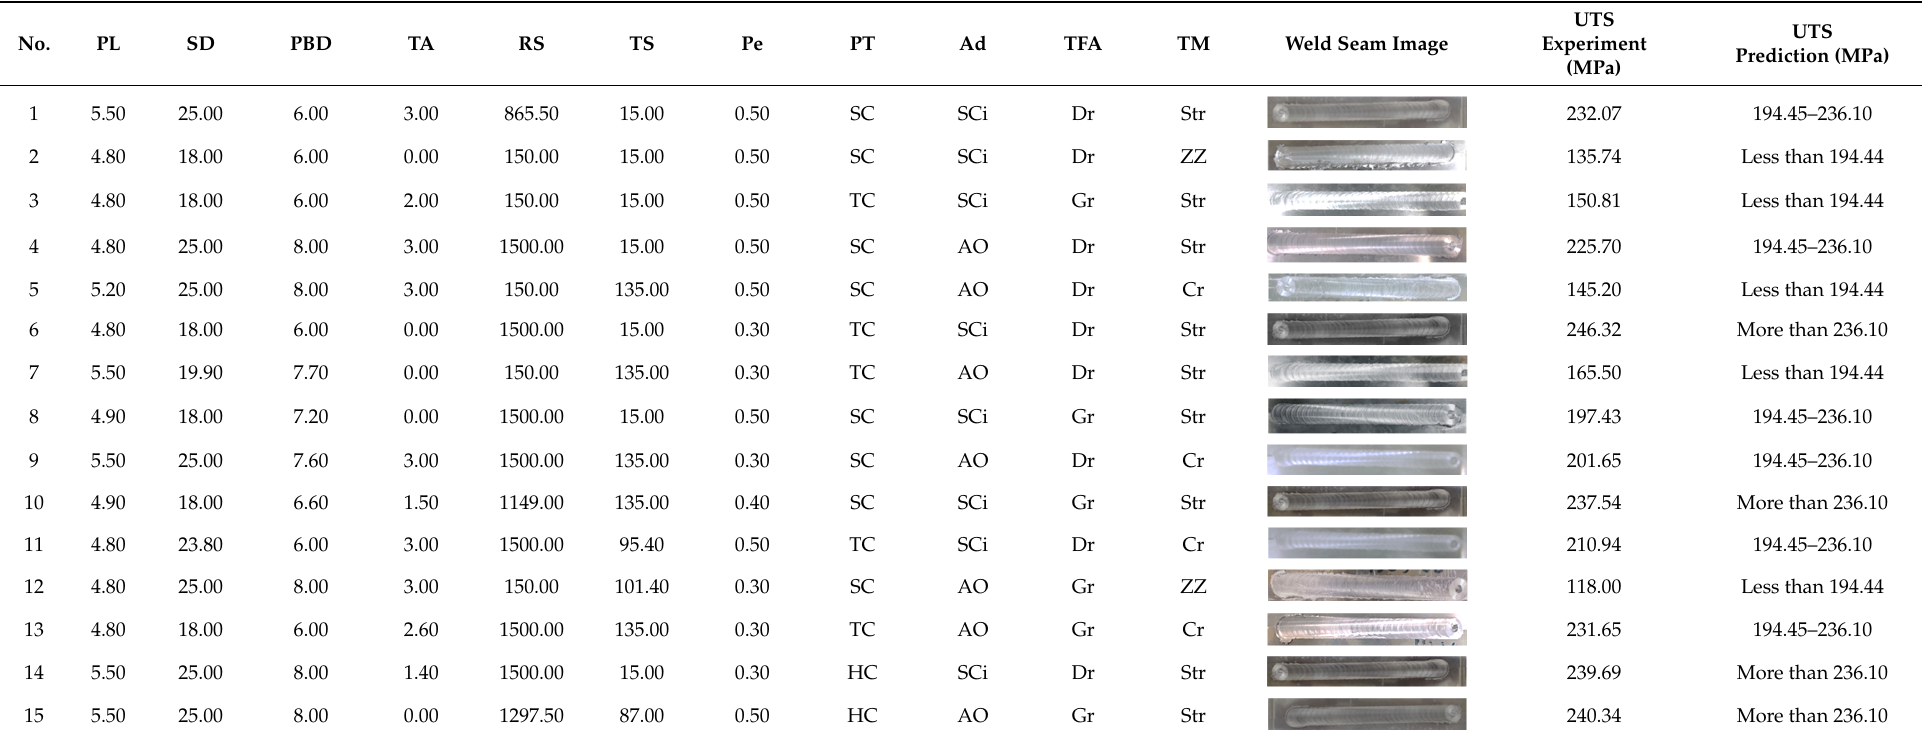
Table 12. Performance metrics of ensemble models for binary dataset.